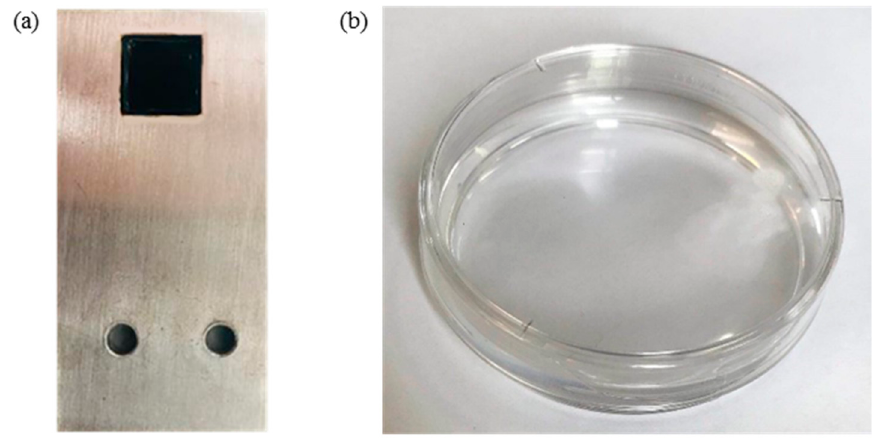
Figure 3. ( a ) Photo of the sample slot for crude oil type detection. ( b ) Photo of the sample cell for